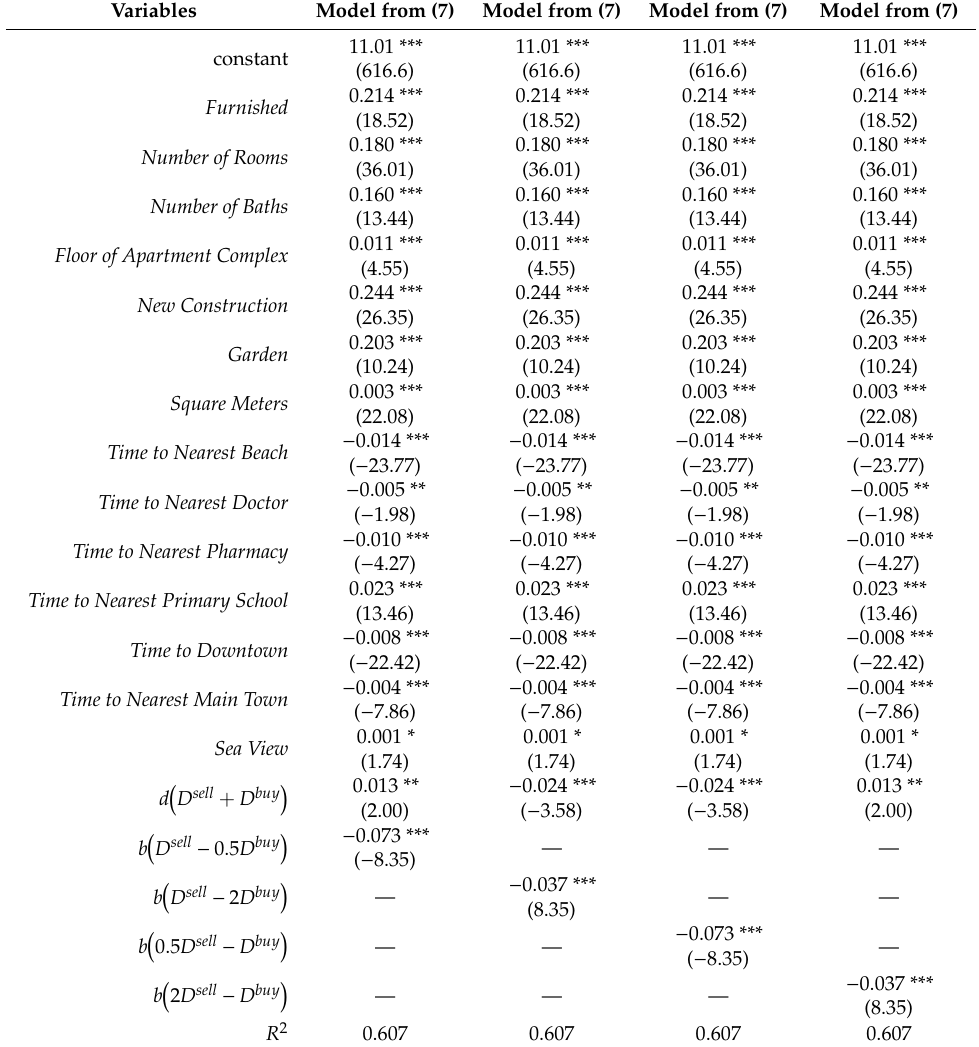
Table 2. Bargaining power regressions with